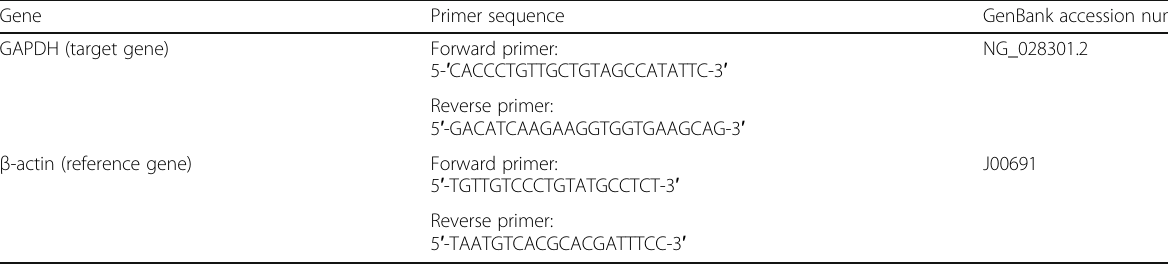
Table 1 Primers of target and reference genes Gene Primer sequence GAPDH (target